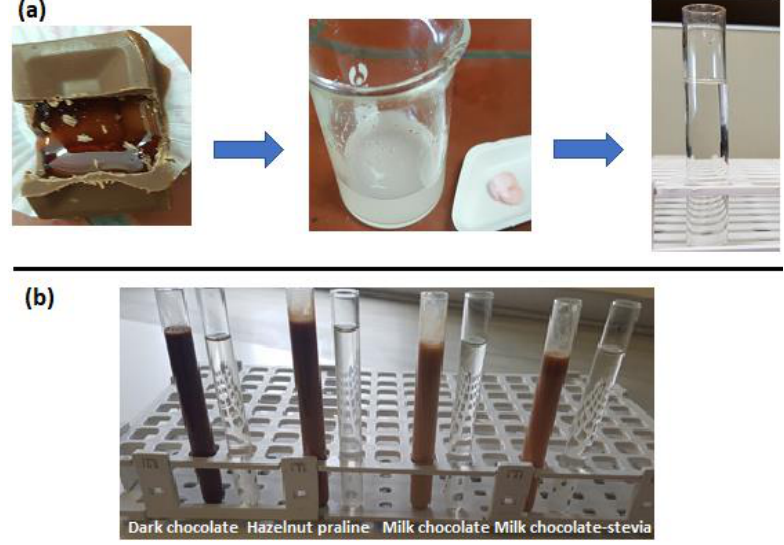
Figure 1. Procedure before and after cleaning-extraction. ( a ) Chocolate-strawberry syrup formulation ( b ) dark chocolate, hazelnut praline, milk chocolate, milk chocolate—stevia.